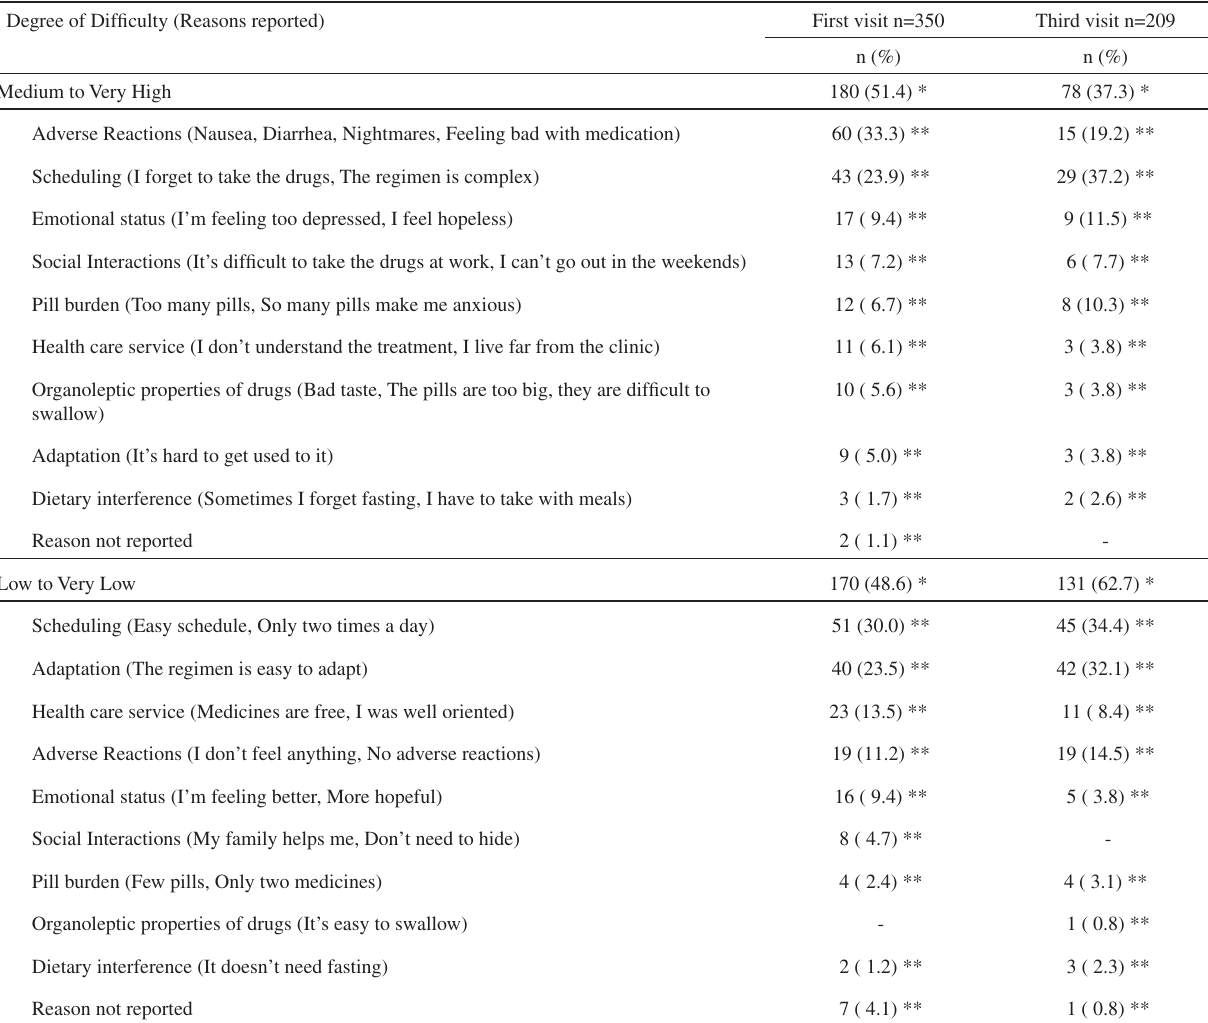
Table 2 - Number and distribution of the degree of difficulties and reasons reported by patients in the first and third visits. ATAR Project, 2001-2003 Degree of Difficulty (Reasons